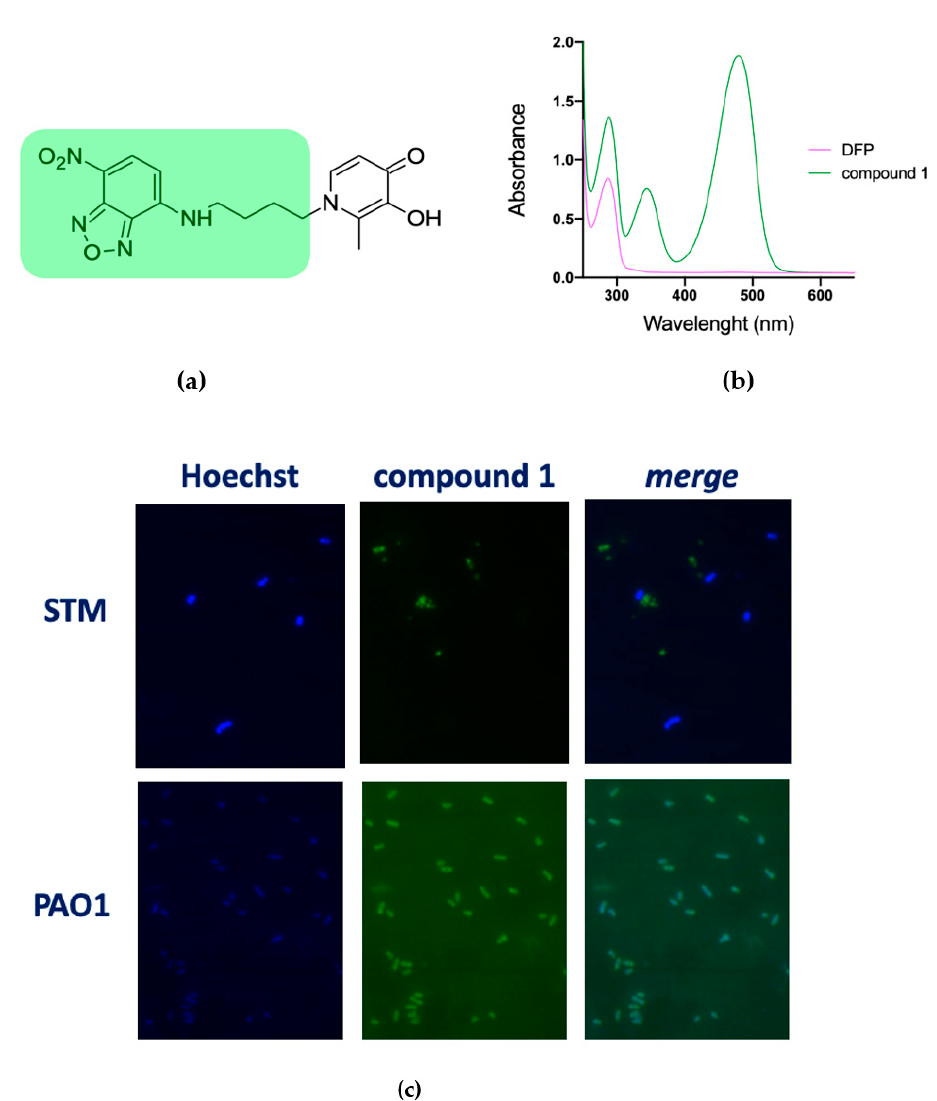
Figure 3. Fluorescence microscopy images of STM and PAO1 cells after treatment with compound 1. ( a ) Chemical structure of 1, highlighting the fluorescent moiety in green. ( b ) Representative ab- sorbance spectrum of compound 1 (green line) compared to DFP (pink line). ( c ) Cells were processed and analyzed by fluorescence microscopy as described in the Materials and Methods. The experi- ments were done independently twice, and the best images are shown here.